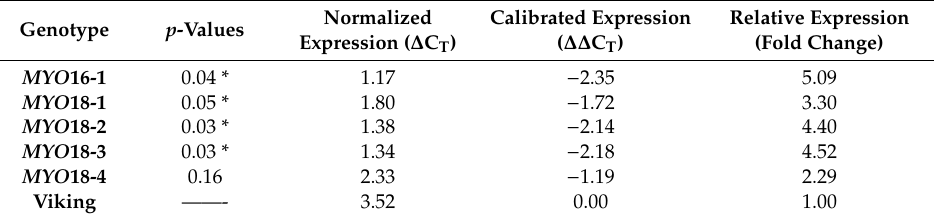
Table 1. qPCR results for di ff erent transgenic lines. Expression is normalized by house-keeping gene MEP and calibrated with Viking genotype.